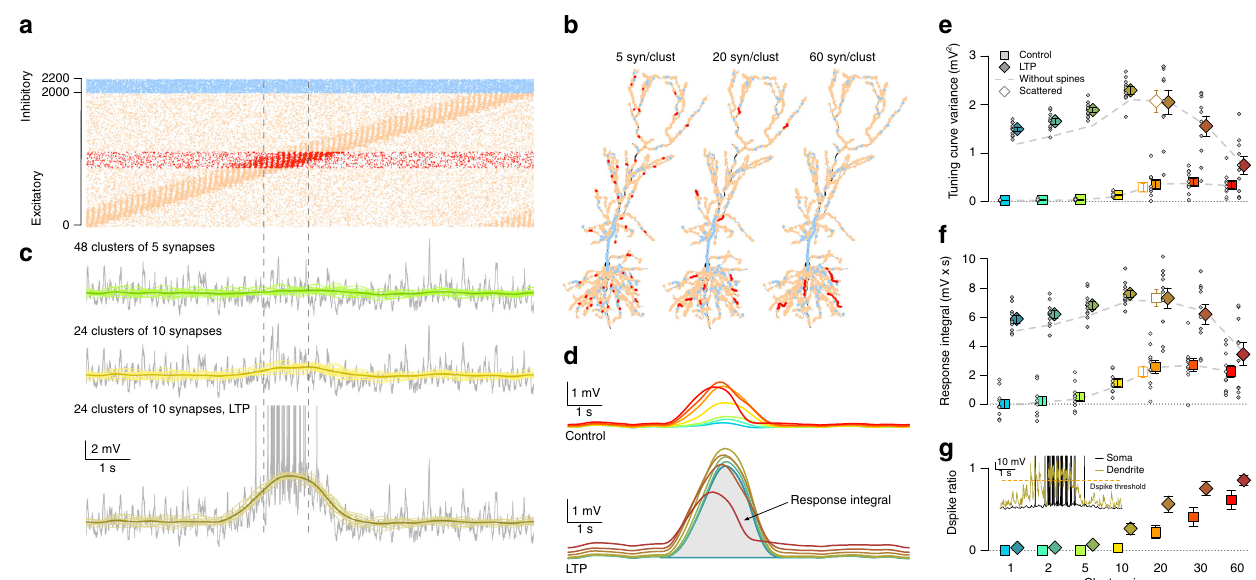
Fig. 3 Larger synaptic clusters can lead to clustering based tuning. Source data are provided as a Source Data fi le. a Excitatory inputs (red) coactive in the middle of the track (dashed vertical lines) were chosen for clustered arrangement. b Branches longer than 60 μ m were selected for arranging 240 synapses (red) into functional synaptic clusters of various size. Examples show clusters of 48 (left), 12 (middle) and 4 (right) synapses. Background excitatory (orange) and inhibitory (blue) synapses are also shown. c Example sVm response of the CA1 neuron (grey), slow V m for 16 trials (green and yellow) and tuning curve (dark green and olive) with 5 (top) or 10 synapses per cluster (middle) or with 10 synapses per cluster combined with LTP of the clustered synapses (bottom). d Average of 10 tuning curves with different input con fi gurations shows increased depolarisation ramp amplitude with clustering (top). Potentiation of the clustered synapses further increases the ramp amplitude (bottom). Colour code is the same as in e – g . e Tuning curve variance as a function of synaptic clustering for control (bright squares) and LTP (dark diamonds) in 10 input con fi gurations (circles) and their means (colour boxes) and SEM (error bars). Grey dashed line indicates the mean without dendritic spines. Open symbols indicate simulations when the 20 synapse per cluster was scattered along a the entire branch receiving clustered input. f Similar to panel e showing the response integral as a function of synaptic clustering. g Mean and SEM of dendritic spike ratio within the place fi eld (dashed lines in a , c ) as the function of synaptic clustering across 10 simulations with 4 dendrites each. Inset shows example somatic and dendritic V m